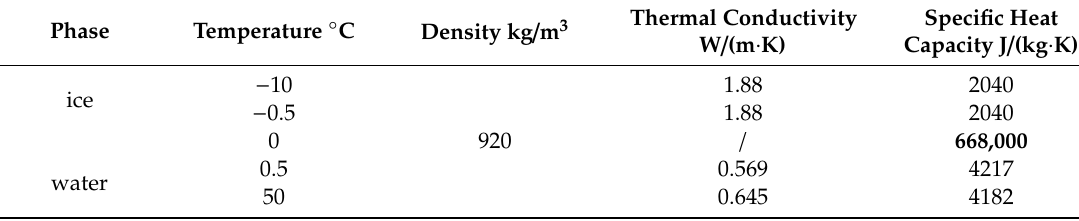
Table 2. Physical properties of the ice and water in